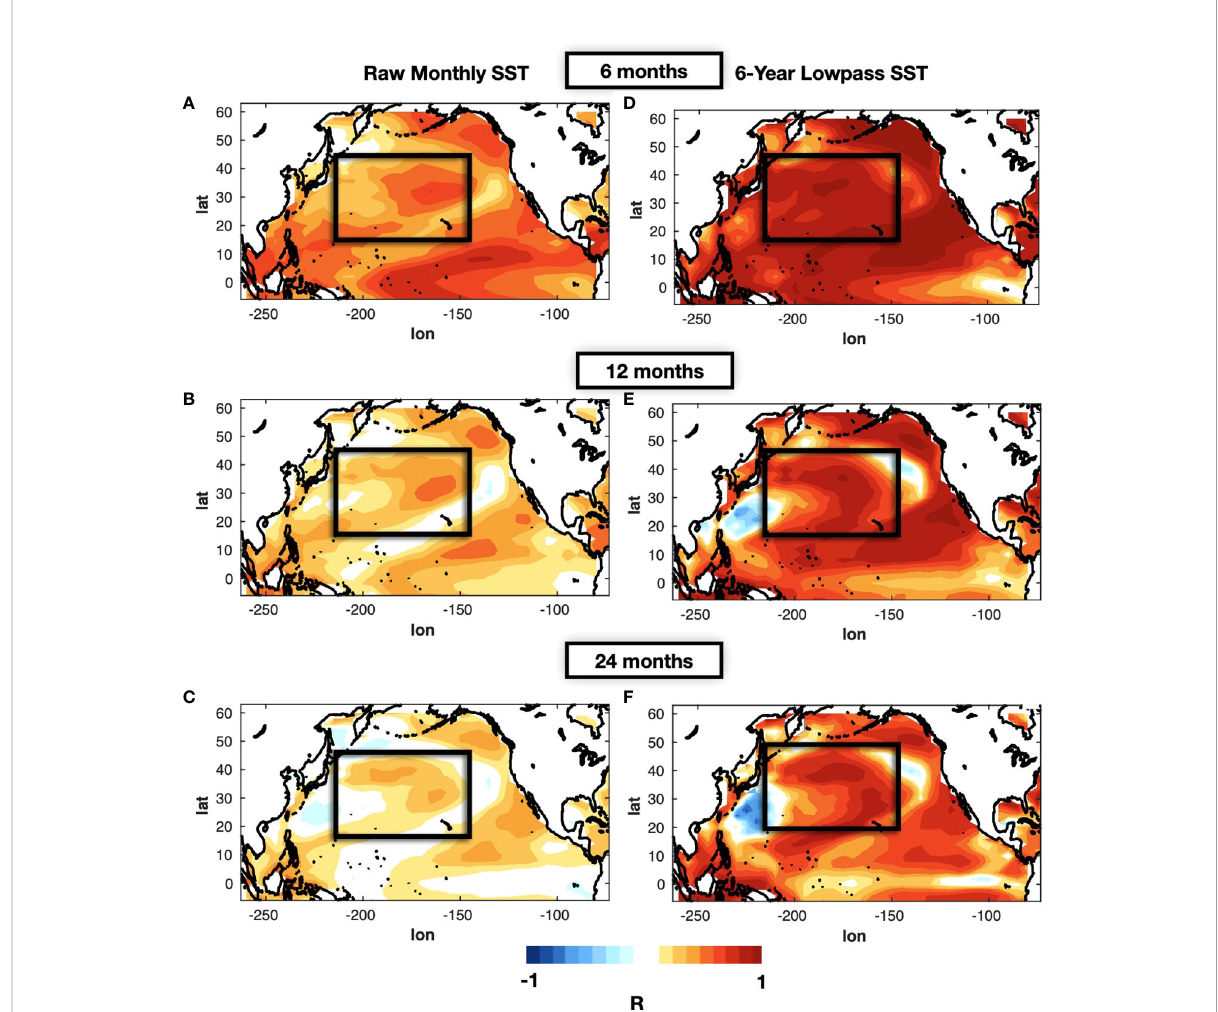
FIGURE 3 Forecast correlation skill of the LIM with physics only (SSTa, SSHa) for lead-times of 6 months (A) , 12 months (B) , and 24 months (C) . In (D) , (E) , and (F) the same correlation skill maps are shown but computed using the 6-year low-pass fi lter applied on the original and forecasted monthly